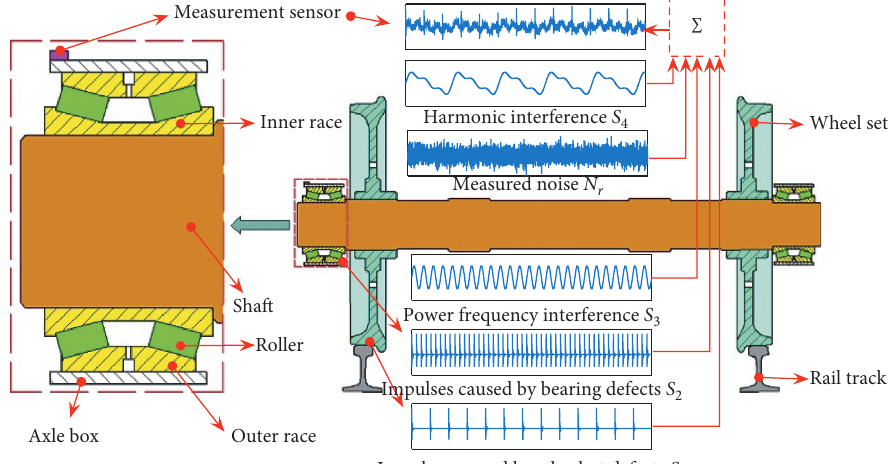
Figure 5: Wheelset bearing system.